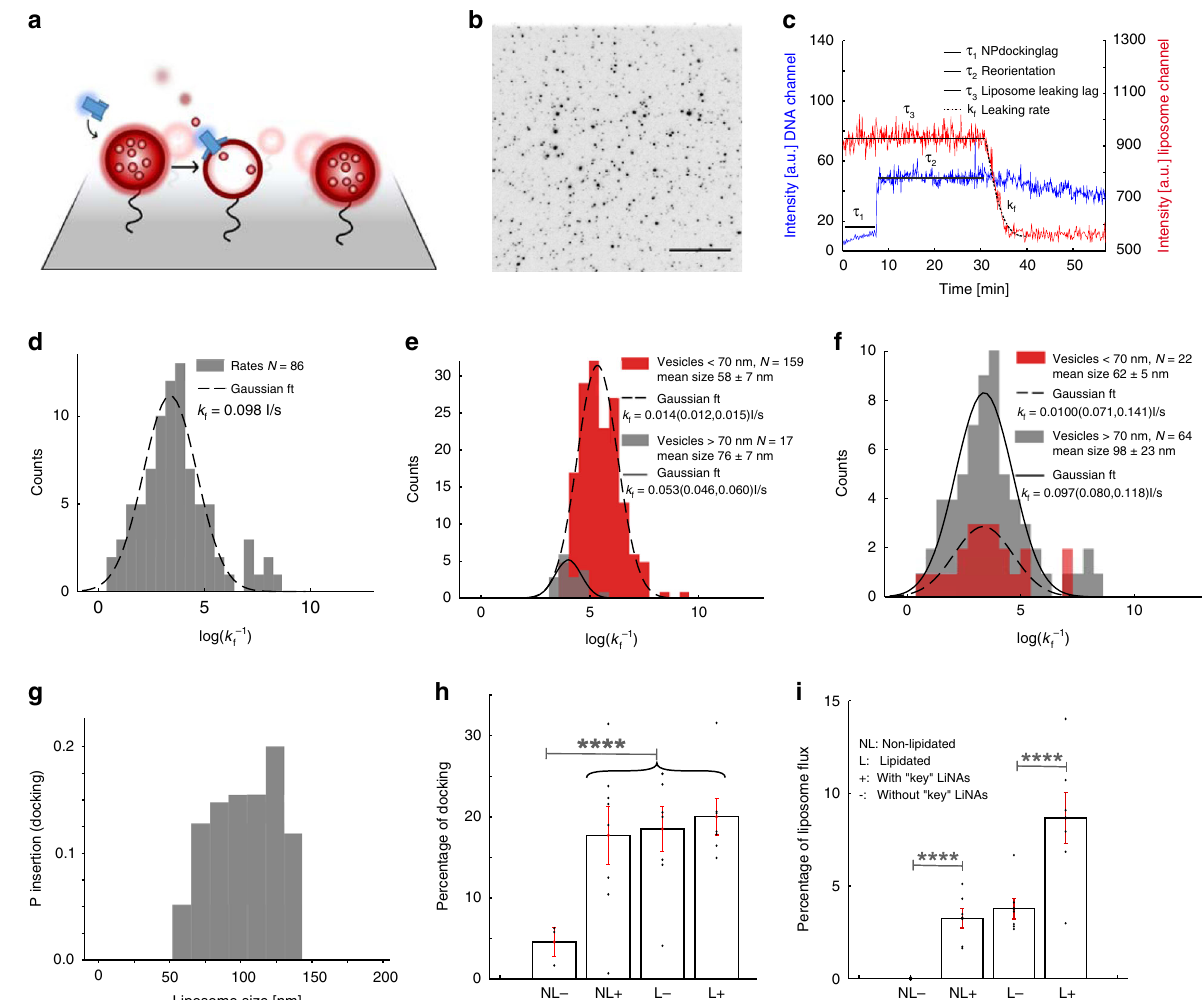
Fig. 3 TIRF studies of DNA nanopores interaction with SUVs. a TIRF setup, to monitor pre-opened lipidated DNA nanopores labeled with ATTO 488 used in ( c ), ( d ), ( f ), and ( g ) and interacting with ATTO 655-loaded SUVs tethered on PLL-PEG-passivated surfaces by a biotin – neutravidin linkage. Insertion of a DNA nanopore allows ATTO 655 ef fl ux. b A single fi eld of view images hundreds of surface-tethered ATTO 655- fi lled SUVs. c Representative traces of an individual nanopore docking (blue trace) on a SUV followed by dye leakage (red trace). The single-particle setup allows real-time observations of the docking time ( τ 1 ), reorientation time for pore insertion ( τ 2 ), as well as the ATTO 655 fl ow rate ( k f ). d Histogram of fl ow rates from 86 recorded ATTO